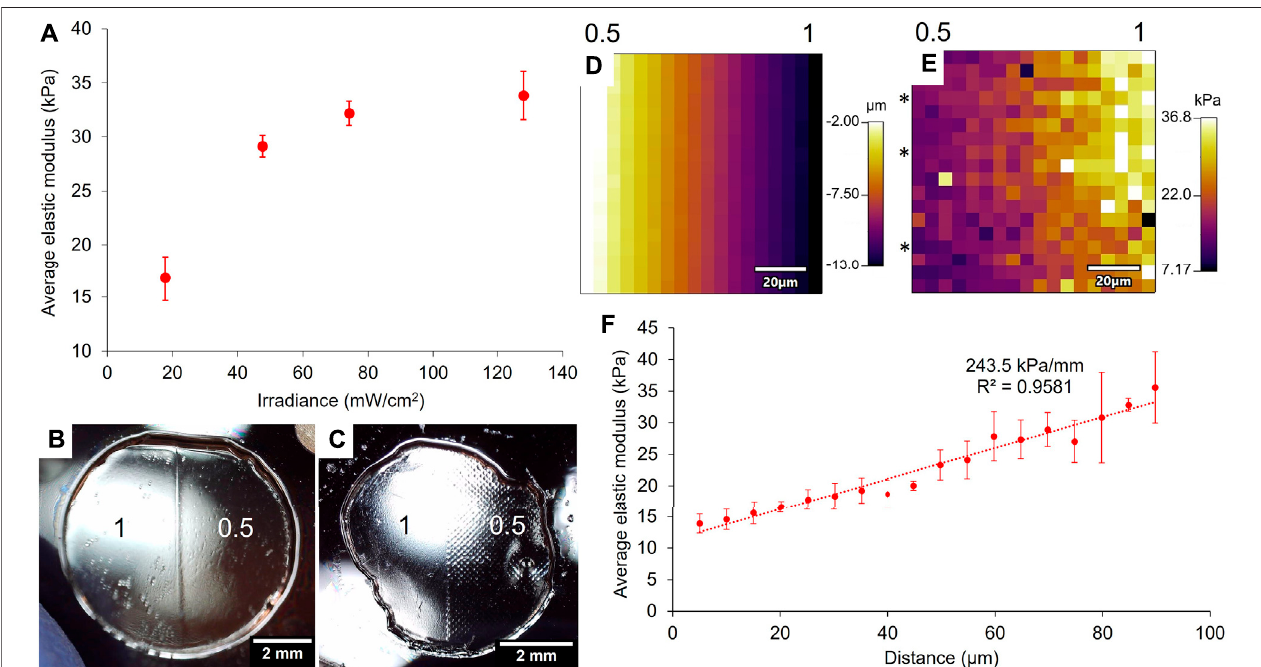
FIGURE6| Relationship betweentheprojectedirradiance andthe10 wt%GelMA gels ’ elasticmoduliafter exposure of4 min (A) .Theaverageelastic modulihave been assessed by force indentation measurements with AFM (error bars: standard error over at least four force maps per area). Images of the gels taken with a USB microscope show that the projector system does not produce sub-patterning over the masked area (B) compared to patterned gels prepared with the printed photomask (C) (scale bars = 2 mm). The numbers on (B,C) are the greyscale values that were applied to the gels. The boundary between the two areas of a 1/0.5 binary gel crosslinked for 3 min was probed with AFM and showed a height gradient (D) as well as a stiffness gradient on the force map (E) (scale bars: 20 μ m). The numbersabove maps (D,E) represent theorientation oftheboundaryintermsofgreyscale values.Threelinesontheforce map (E) wereaveraged(linesidenti fi edwith*) and plotted against the distance to show the strength of the gradient (F) (error bars: standard error of the mean over the three lines).